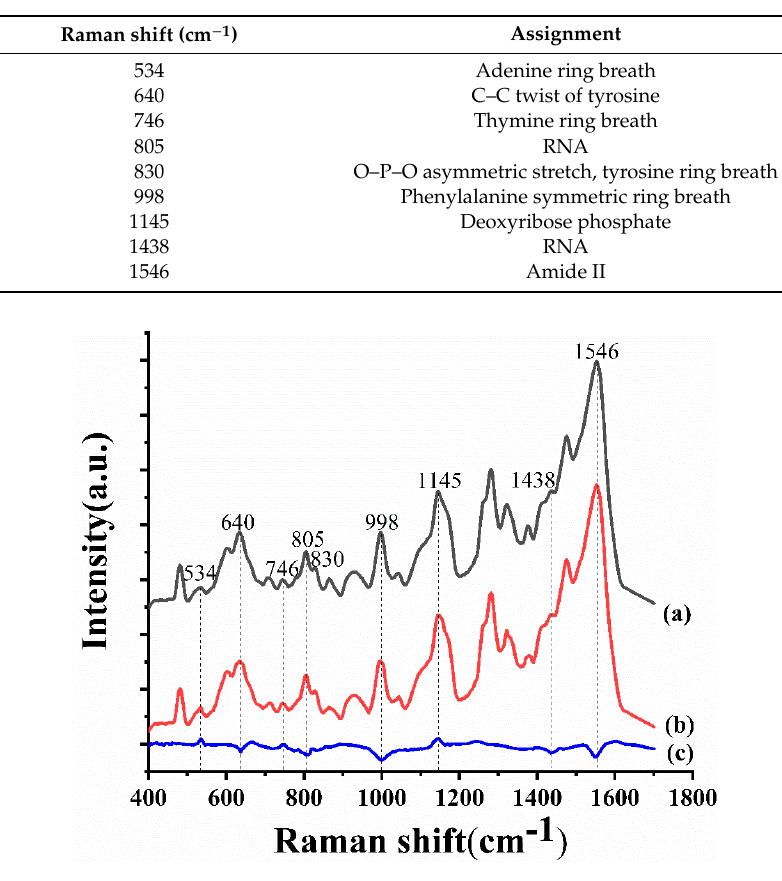
Figure 3. SERS spectral changes of HeLa cells treated with cordycepin in the early stage of apoptosis. ( a ) The average SERS spectrum of the control group; ( b ) the average SERS spectrum of the cordycepin-12 h group; ( c ) spectral difference between (b) and (a). The x-axis is the Raman shift and y-axis is the intensities in arbitrary unit